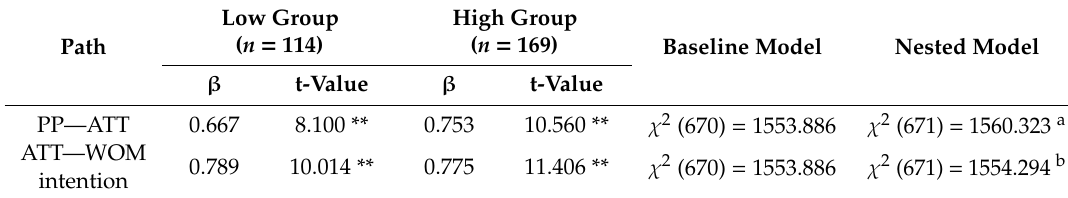
Table 5. Results for the moderating role of innovativeness.